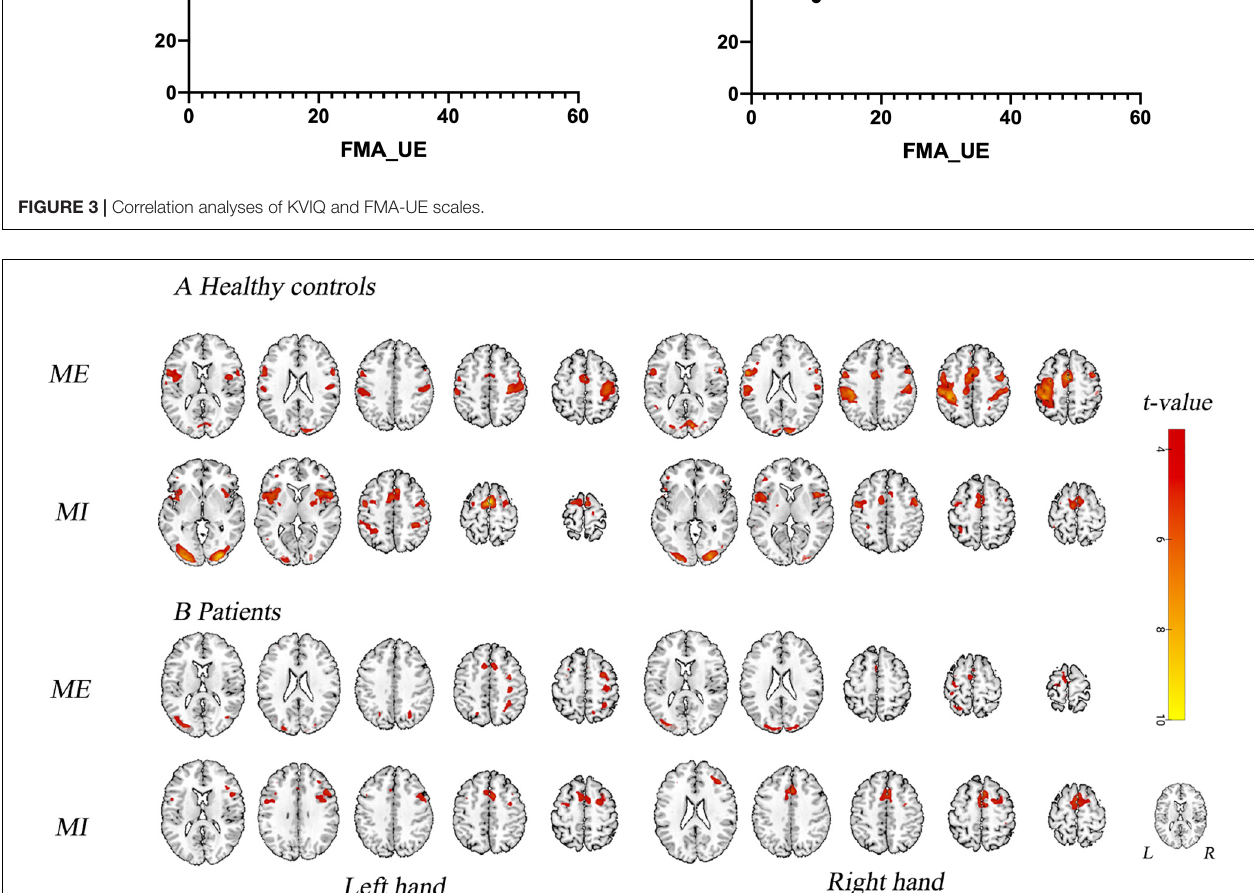
FIGURE 4 | Activation map. Brain activity in different experimental conditions is shown. (A) During active motor execution and motor imagery in healthy controls. (B) During motor execution and motor imagery in stroke patients. Left hand: activation patterns for tasks performed with the left hand, i.e., unaffected hand (UH) in patients. Right hand: activation patterns for the tasks performed with the right hand, i.e., affected hand (AH) in patients. MNI coordinates of an axial slice for visualization are shown. L, left hemisphere; R, right